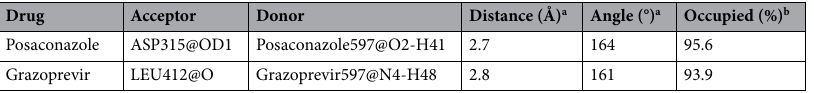
Table 3. Hydrogen bonds exhibited between the key residues and the most promising drugs against SARS- CoV-2 helicase. a The hydrogen bonds are inspected by the acceptor–donor atom distance of < 3.5 Å and acceptor-H-donor angle of > 120°. b Occupancy is employed to estimate the stability and strength of the hydrogen bond.